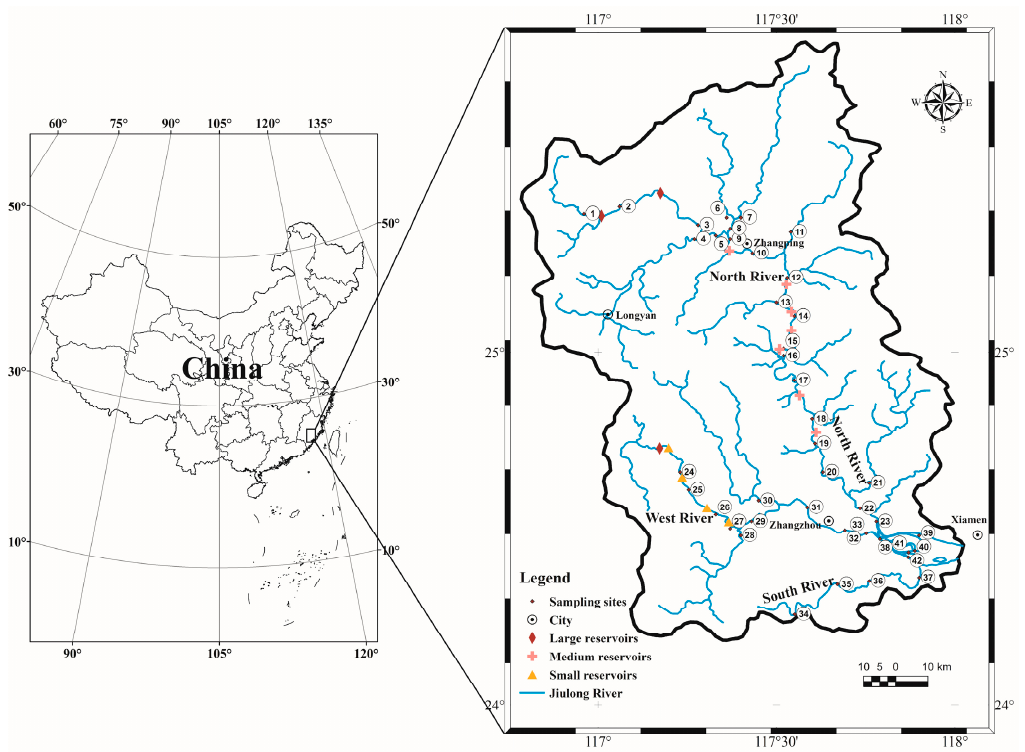
Figure 1. Drainage map of the Jiulong River and the sampling sites.